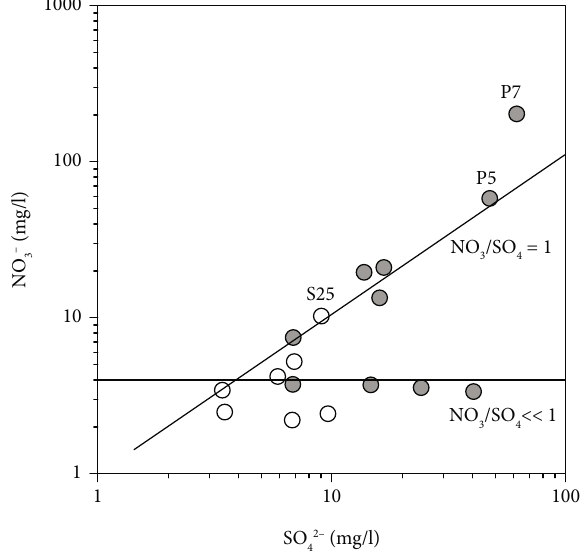
Figure 10: Relationships between SO 42- and NO 3- contents in HAV water samples. The water samples with NO 3- values lower than detection limit (1.9 mg/l) are not reported. P5 and P7 water samples have higher NO 3- values. The NO 3- geogenic level (equal to 4mg/l) has been drawn. The symbols are as Figure